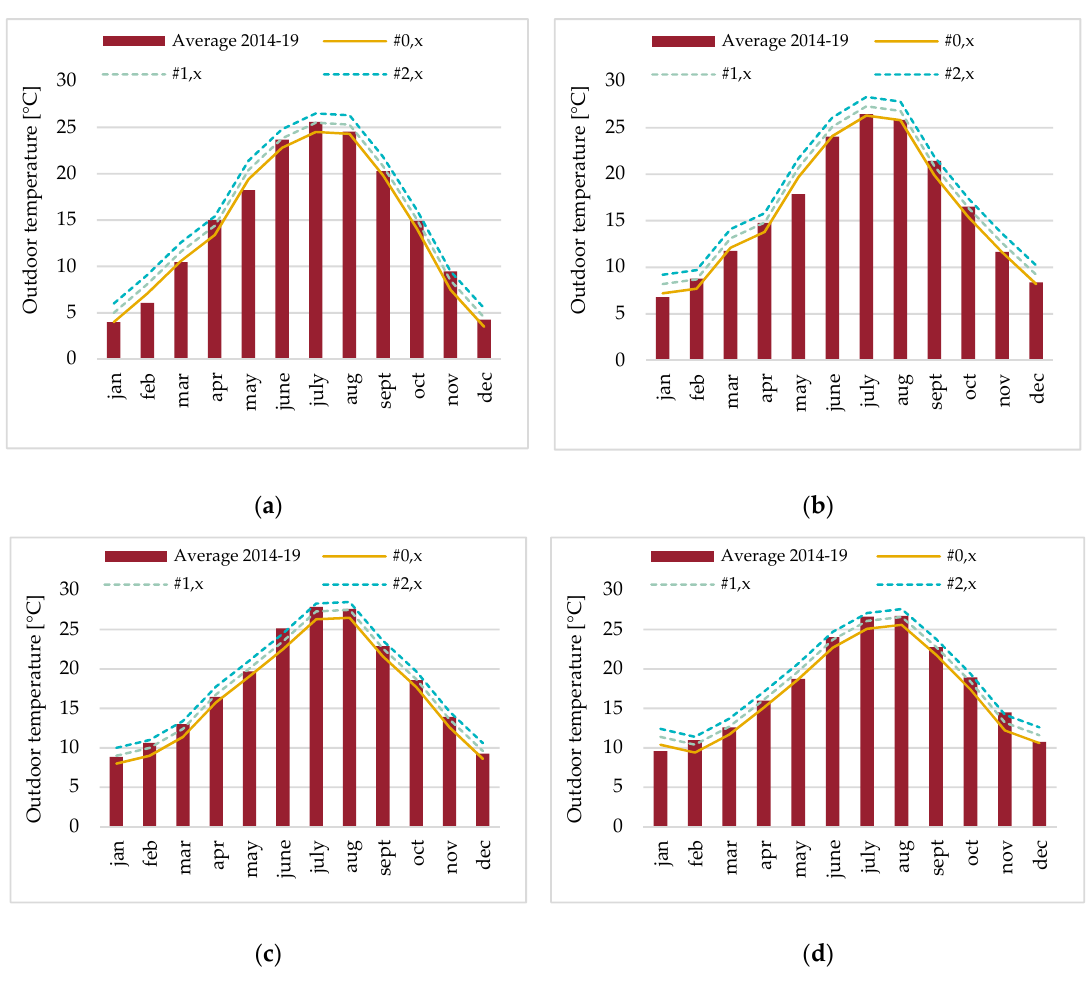
Figure 2. Comparison between simulated data and the climate average data related to years 2014–2019; ( a ) Milan; ( b ) Florence; ( c ) Rome; ( d ) Naples.